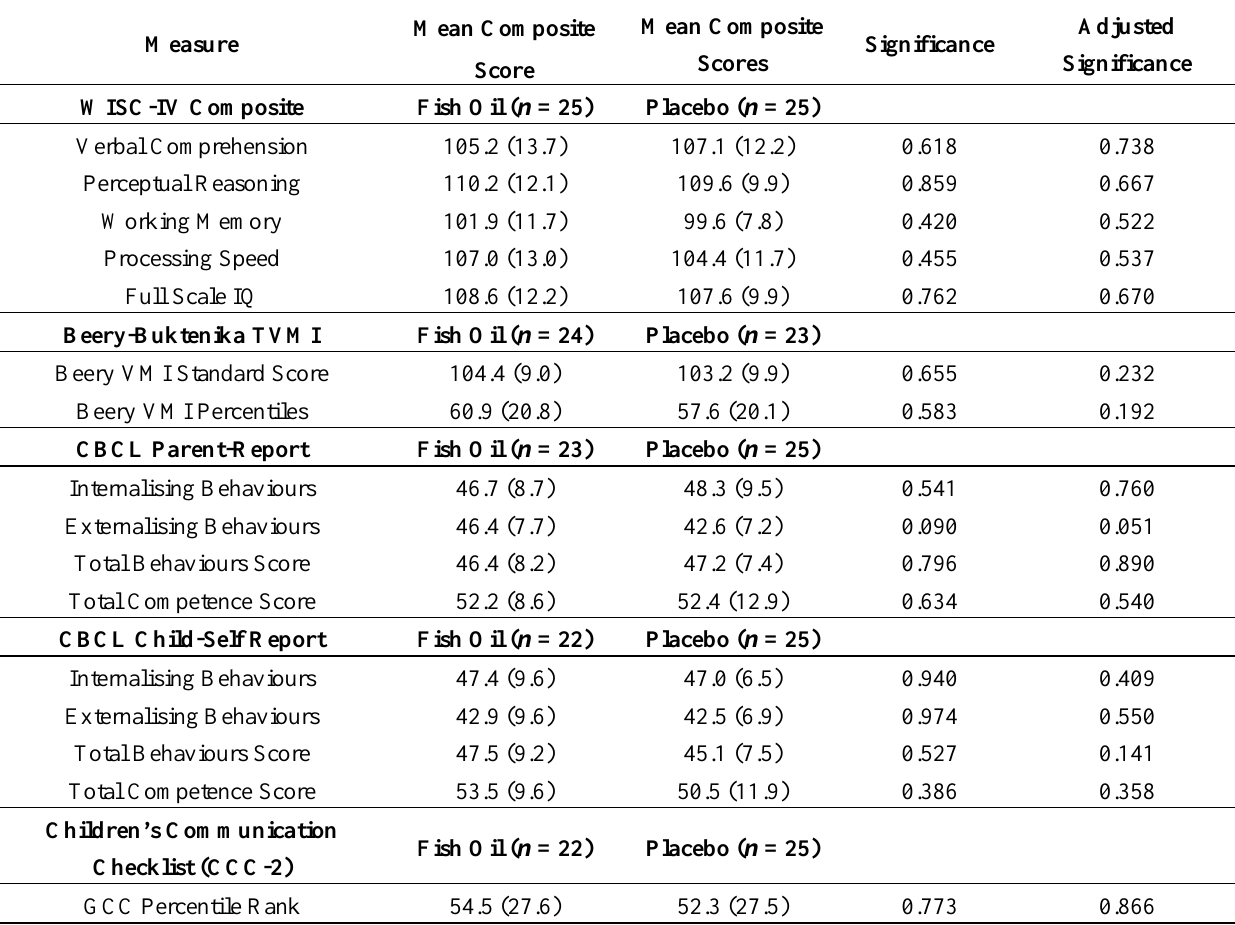
Table 1. Mean composite scores and percentile ranks for both supplementation groups